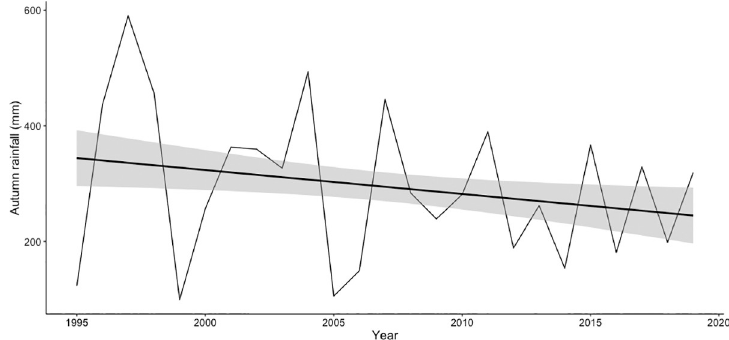
Fig 3. Variation of autumn rainfall in milimeters (September-December) over the study period. Points represent actual data and line represents the linear regression.